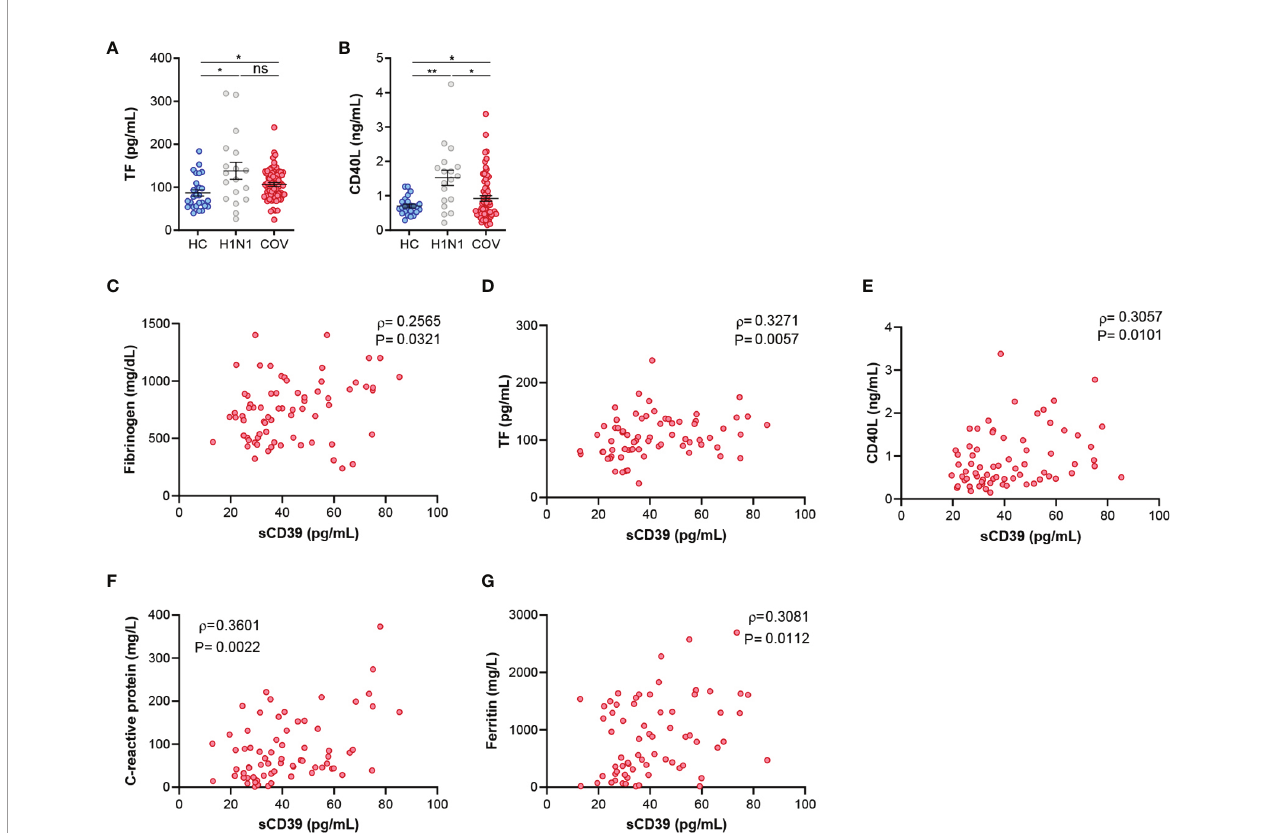
FIGURE 3 | Elevated coagulation and in fl ammation markers in COVID-19 patients are associated with sCD39. (A) ELISA quanti fi cation of TF plasma levels in healthy controls (HV, n=27), in fl uenza A patients (H1N1, n=18) and COVID-19 patients (COV, n=70). (B) ELISA quanti fi cation of CD40L plasma protein expression in healthy controls (HC, n=24), in fl uenza A patients (H1N1, n=18) and COVID ‐ 19 patients (COV, n=70). Mean differences were analyzed using unpaired Student ’ s t-test analysis with Welch correction. Error bars: mean ± SEM. *P < 0·05; **P < 0·01. (C – E) Correlations between sCD39 and (C) fi brinogen (n=70), (D) TF (n=70) and (E) CD40L (n=70). (F) Correlation between sCD39 plasma levels and C-reactive protein plasma concentration (n=70) or (G) ferritin plasma concentration (n=67). Spearman ’ s correlation coef fi cients ( r ) and P-values (P) are shown. ns, non signi fi